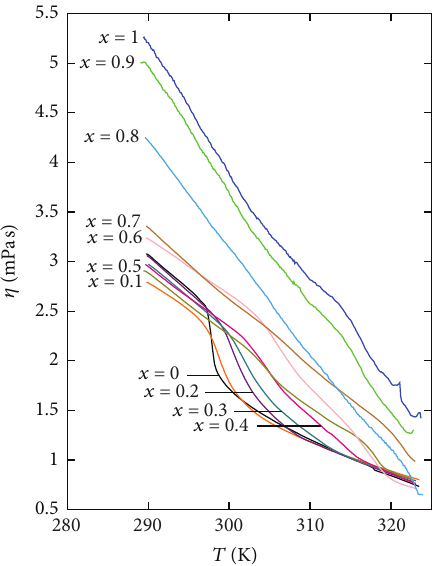
Figure 11: Temperature dependence of the calculated effective viscosity 𝜂 of a supported vesicle layer of DMPC + DSPC mixtures onagold-coatedQCM-Dquartzsensor. 𝑥 referstothemolefraction of